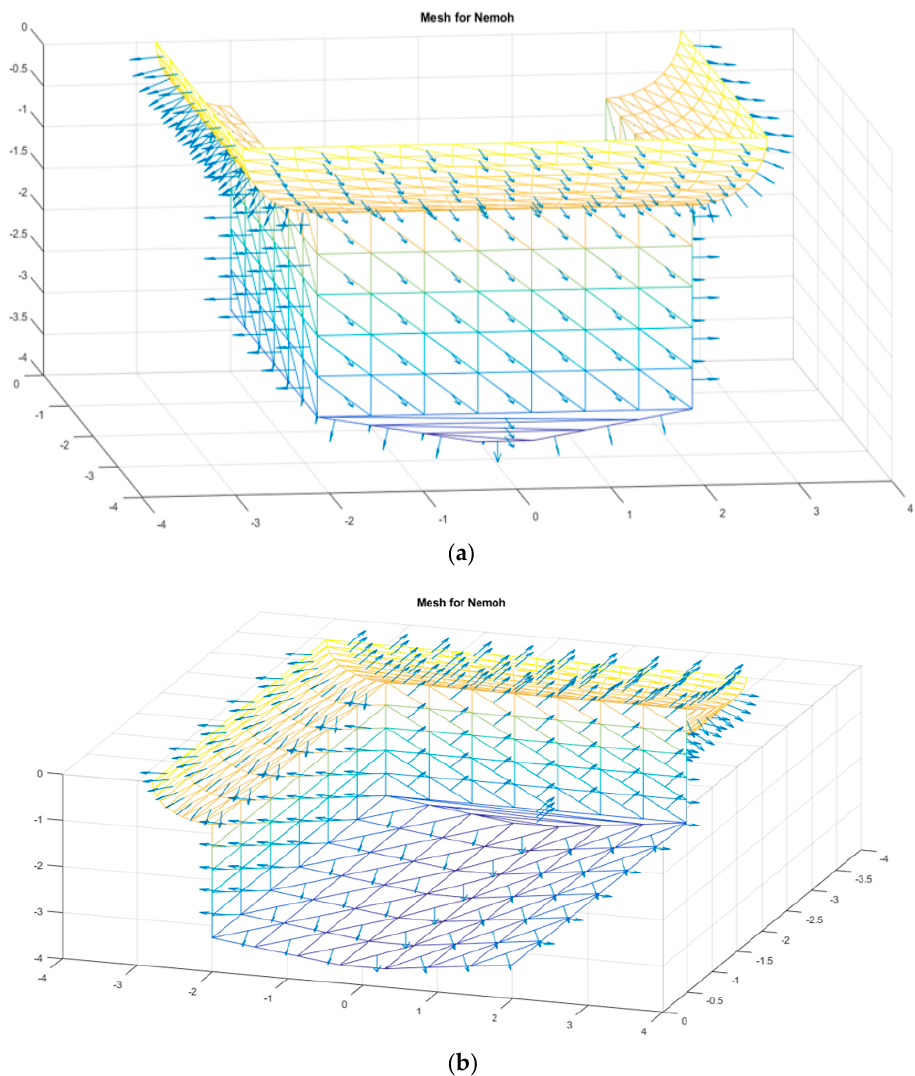
Figure 7. The mesh generated for a sample geometry in the NEMOH software with 326 panels in ( a ) front view; ( b ) bottom view.